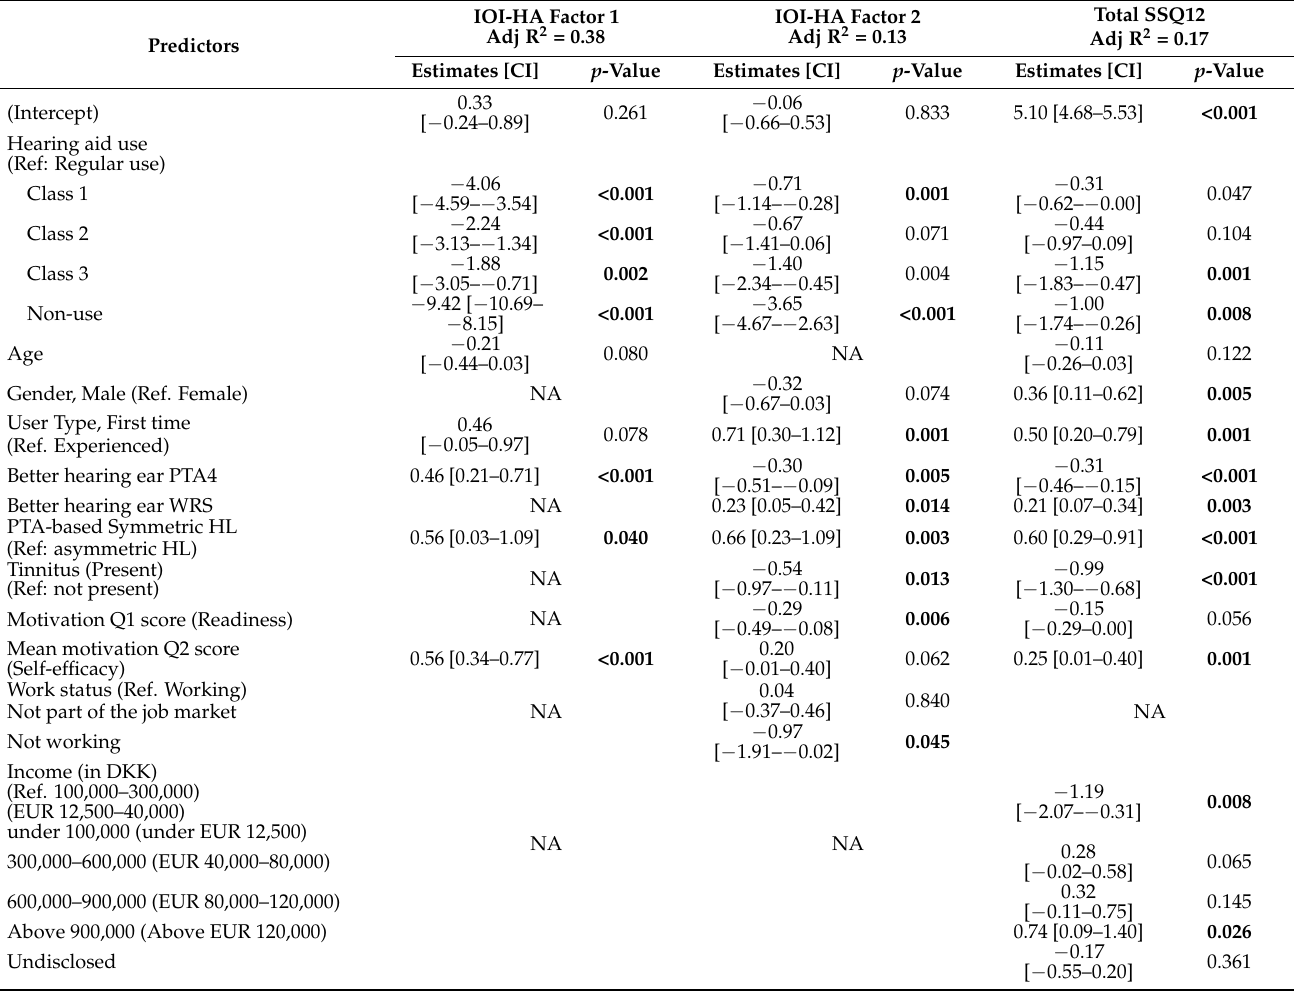
Table 3. Stepwise multiple linear regression analysis of two IOI-HA Factor scores and total SSQ12 scores for situations where HA users always put on their hearing